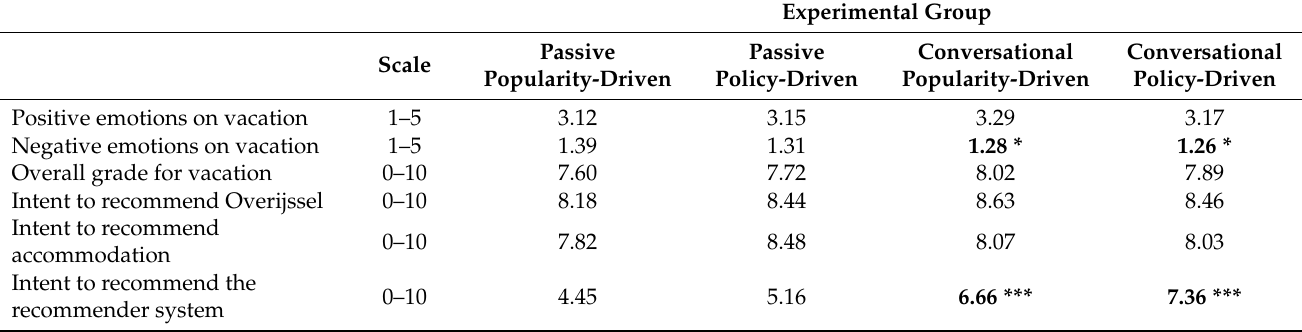
Table 1. Self-reported differences between groups including inferential comparisons to passive popularity-driven